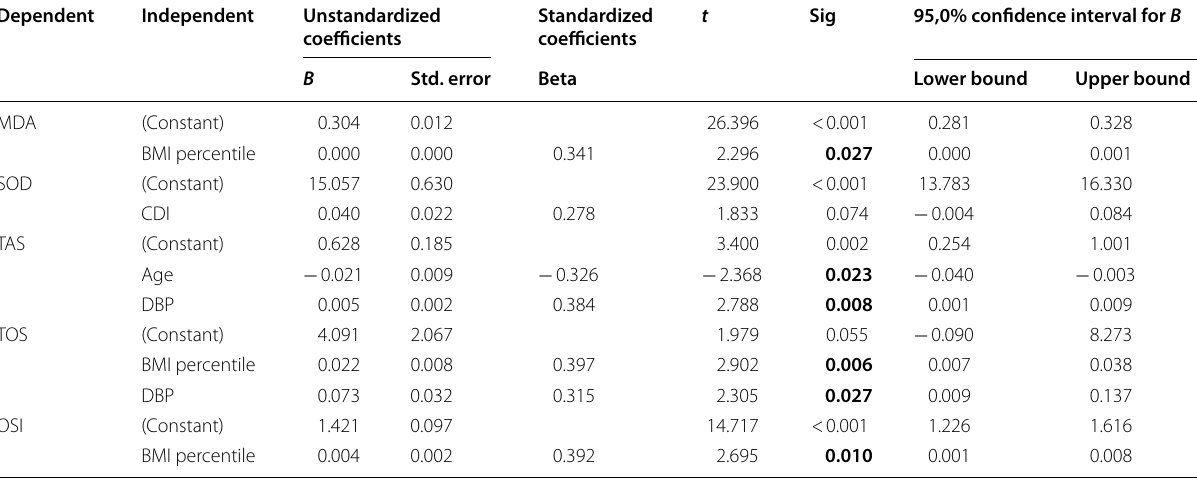
Bold indicates p -value Linear Regression Analysis